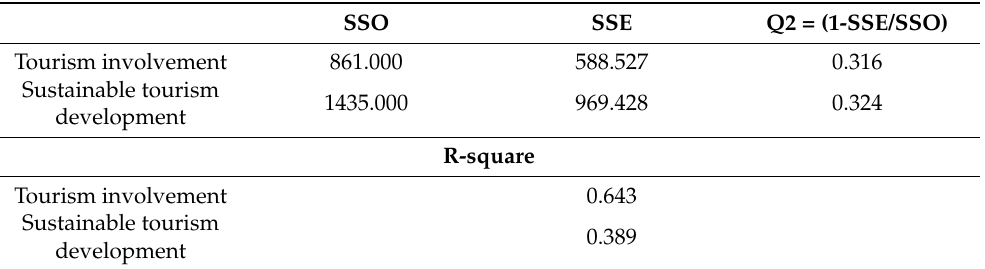
Table 6. Cross-validated redundancy (Q 2